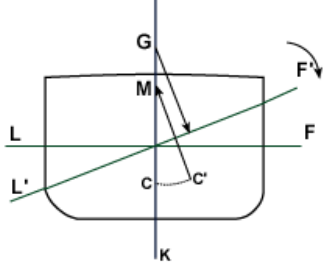
Figure 6. Combinations of force vectors.